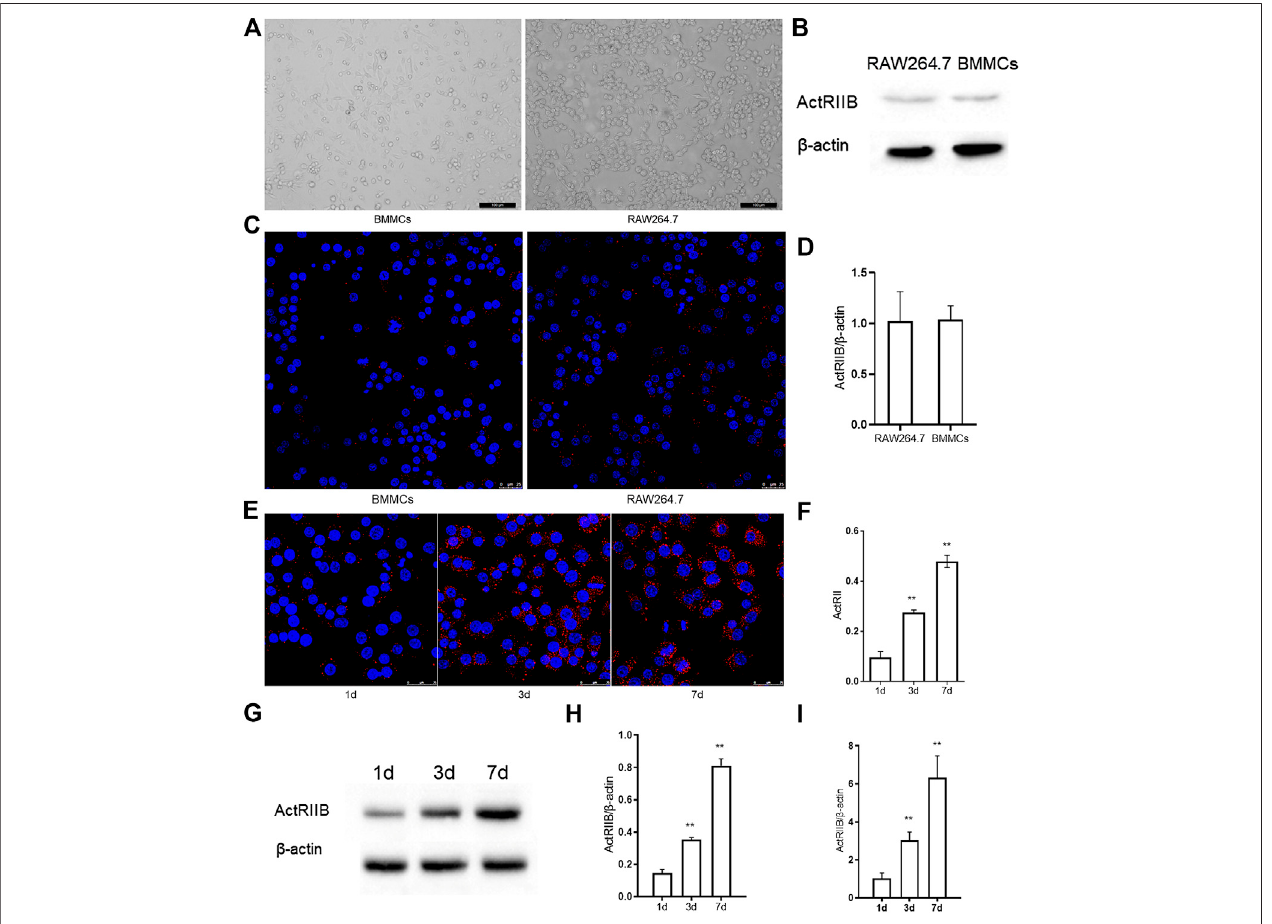
FIGURE1| Theexpression ofActR IIB increases during osteoclastogenesis. (A) Cells werevisualizedbyan inverted opticalmicroscope. (B) ActR IIBprotein was extractedforanalysisbywesternblot. (C) Immuno fl uorescence stainingofActRIIBinRAW264.7 cellsandBMMCs. (D) RT-PCR wasused todeterminetheexpression of ActR II B. (E,F) Immuno fl uorescence staining ofActR II Bin RAW264.7 cells and BMMCs ondays 1, 3, and 7. (G,H) Lyzed protein from induced RAW264.7 cells was analyzed by western blotting. (I) Total RNA was analyzed by RT-PCR to examine the expression of mRNA. ** p < 0.01.